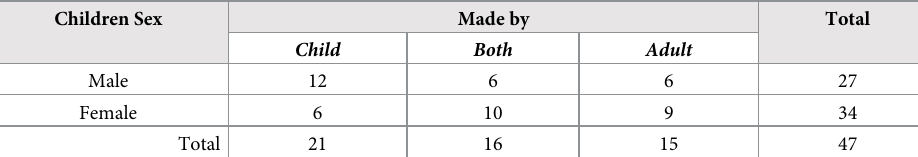
Table 8. Distribution of boys and girls participation with women. Children Sex